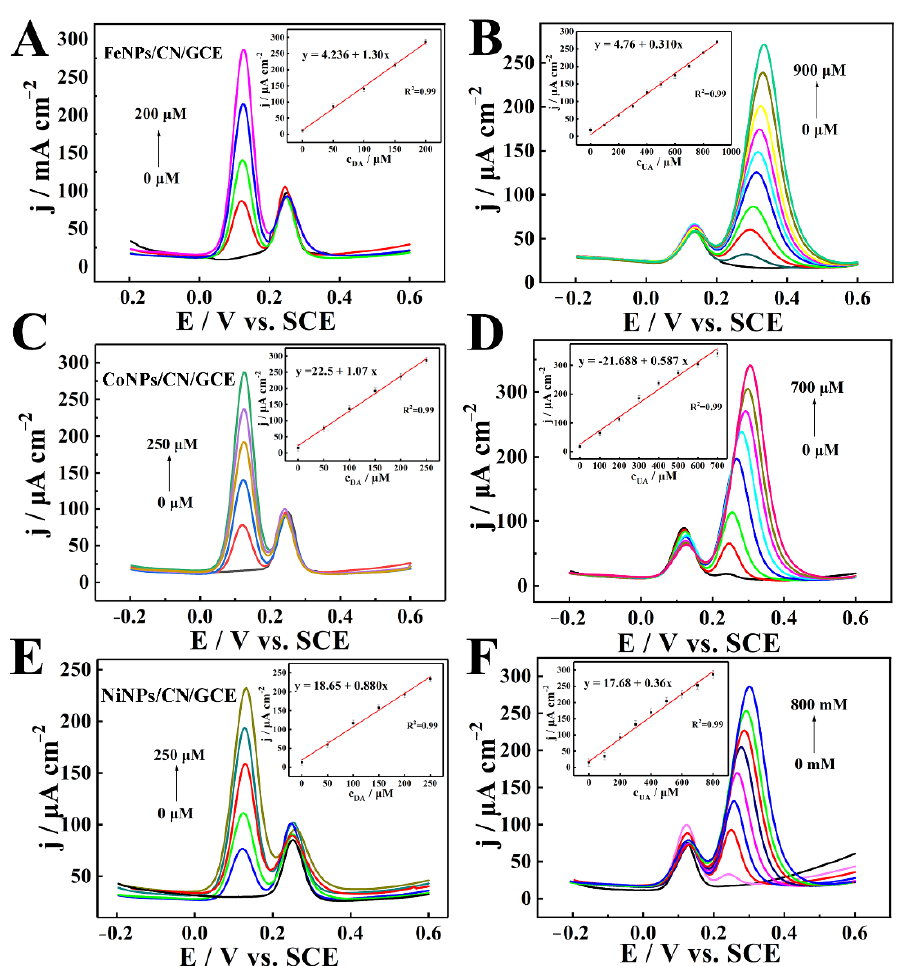
Figure 6. ( A , C , E ) DPV of FeNPs/CN/GCE, CoNPs/CN/GCE, NiNPs/CN/GCE in 0.2 M N 2 -statured PBS (pH = 7) containing UA to detect DA. ( B , D , F ) DPV of FeNPs/CN/GCE, CoNPs/CN/GCE, NiNPs/CN/GCE in 0.2 M N 2 -statured PBS (pH = 7) containing DA to detect UA. Insets: plots of peak current density versus concentration.